Question: Condense the content of this figure into a single sentence.
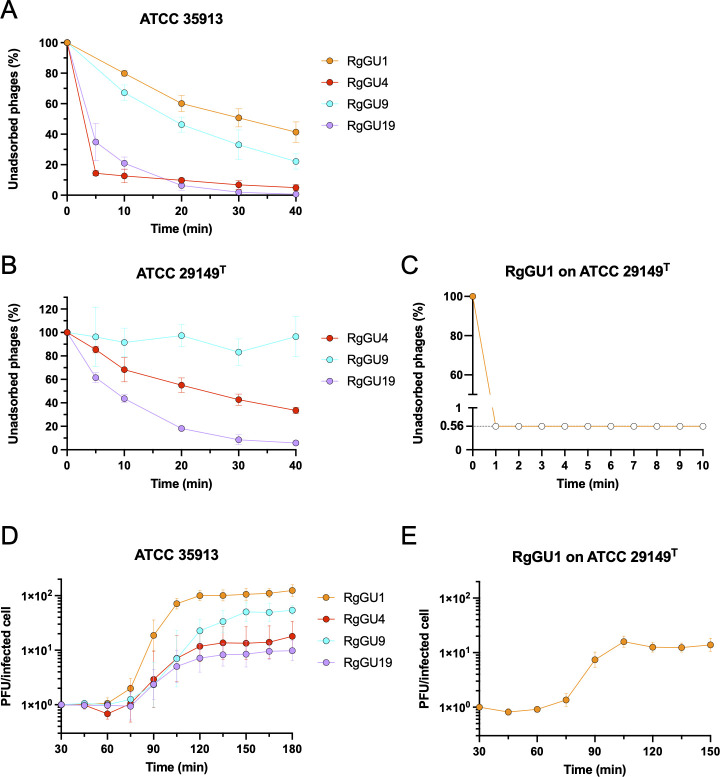
Answer: Adsorption kinetics and one-step growth curve of representative R. gnavus phages. ( A ) Adsorption kinetics of RgGU1, 4, 9, and 19 by R. gnavus ATCC 35913. Host bacteria were infected with each phage and incubated at 37°C. The titer of the unadsorbed phages was determined at the indicated time points. Experiments were performed in triplicate, and the mean ± SD is shown. ( B ) Adsorption kinetics of RgGU4, 9, and 19 on R. gnavus ATCC 29149ᵀ. ( C ) Adsorption kinetics of RgGU1 on R. gnavus ATCC 29149ᵀ. The assay was performed as described in panel A. The detection limit (shown as a dotted line) was 0.56%, and the open circles indicate values below this threshold. ( D ) One-step growth curves of RgGU1, 4, 9, 19 in R. gnavus ATCC 35913. Host bacteria were infected at an MOI of 0.1 and incubated at 37°C. The titer of the progeny phages was determined at the indicated time points. All experiments were performed in triplicate and independently repeated three times. Data are presented as mean ± SD. ( E ) One-step growth curve of RgGU1 in R. gnavus ATCC 29149 T . The assay was performed as described in panel C.